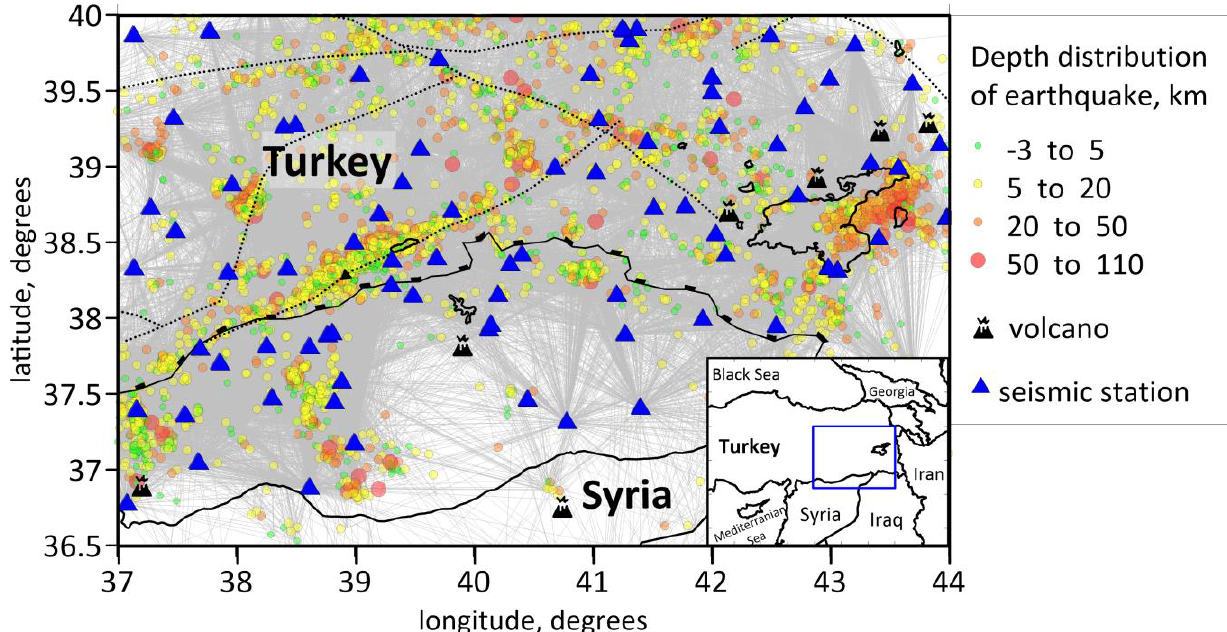
Figure 2. Distribution of data used for seismic tomography in the study region. Blue triangles denote seismic stations. Red dots are the events. Grey lines indicate the horizontal projection of the ray-path.